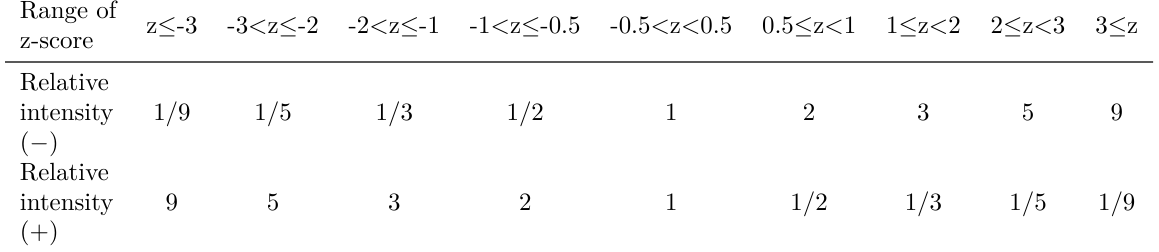
Table 1. Conversion of in-cluster mean z-scores to relative intensities for calculation of